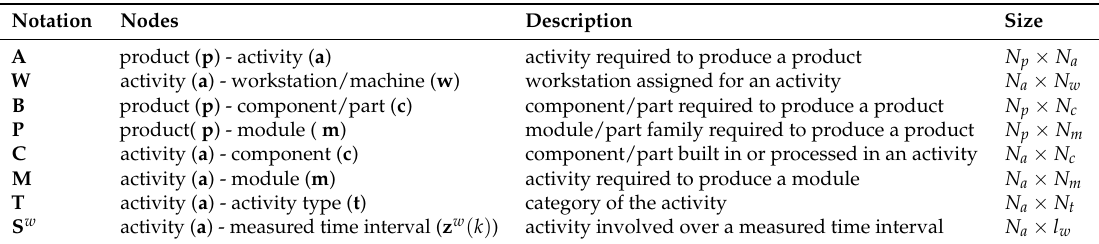
Table 1. The logical matrices defined for performance